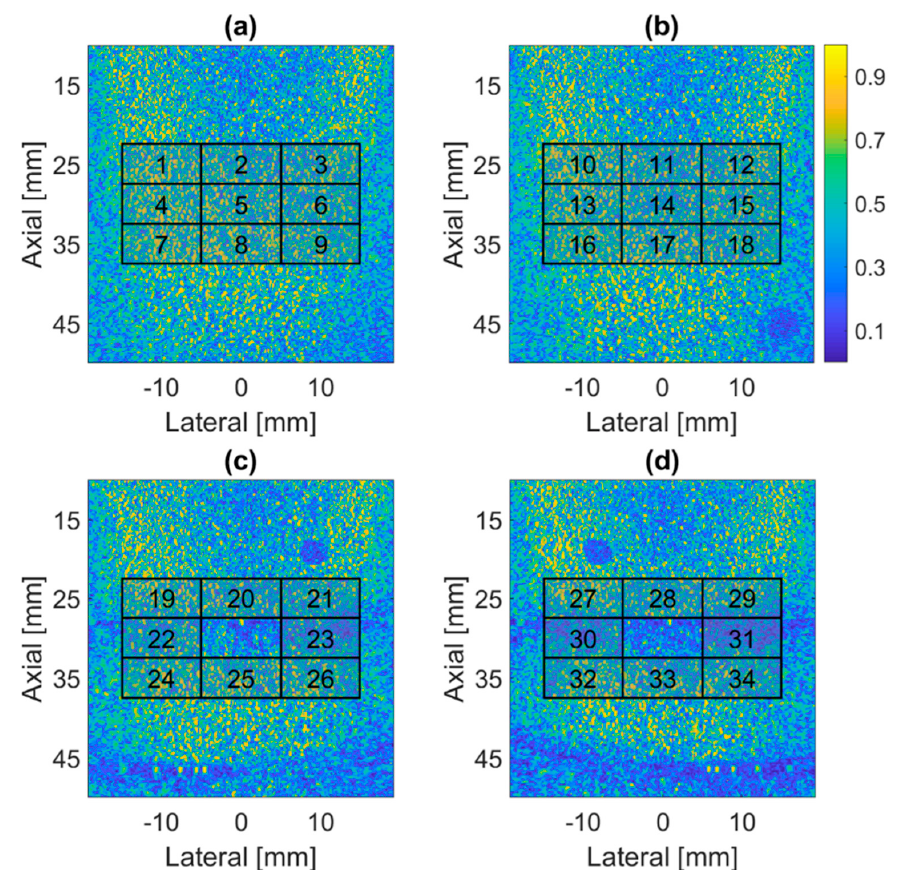
Figure 11. ( a – d ) DCF map of Tx-DMAS beamforming for four different FOVs of Prodigy experimental phantom. The black rectangular ROIs labeled from 1 to 34 are used for SOS estimation.